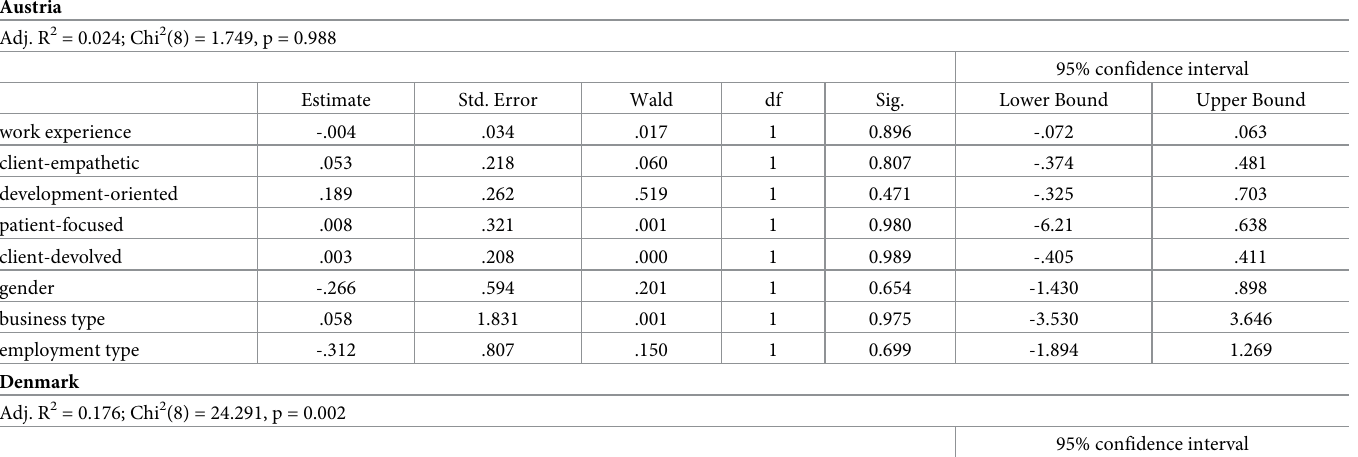
Table 7. Ordinal regression analysis (including work experience) to predict frequency of discussion among veterinarians and dog and cat owners about health insurance.